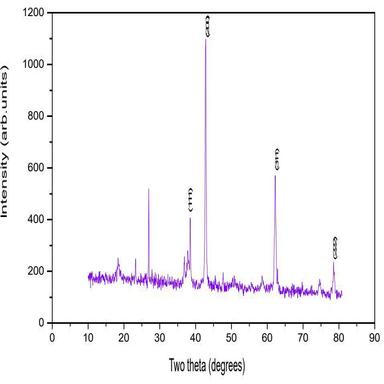
PXRD pattern of RbCl doped MgO nanoparticles.